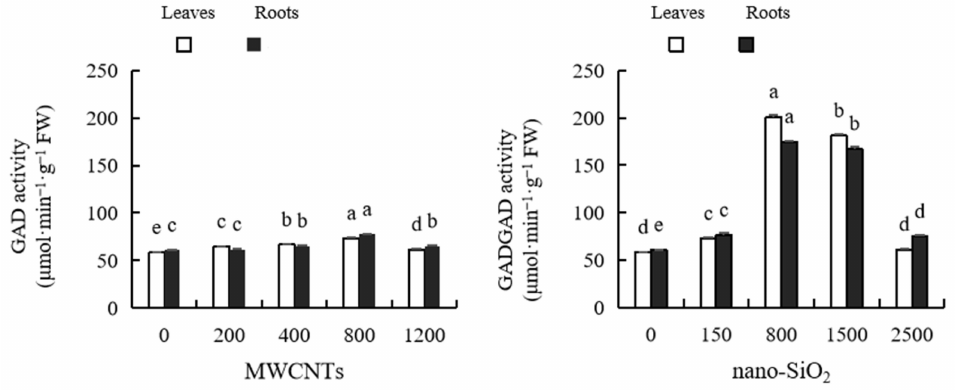
Figure 10. Effect of different concentrations of MWCNTs and nano-SiO 2 on GAD activity in maize. Note: Data are expressed as mean ± standard deviation. Different letters within the same column indicate significant difference at 5%